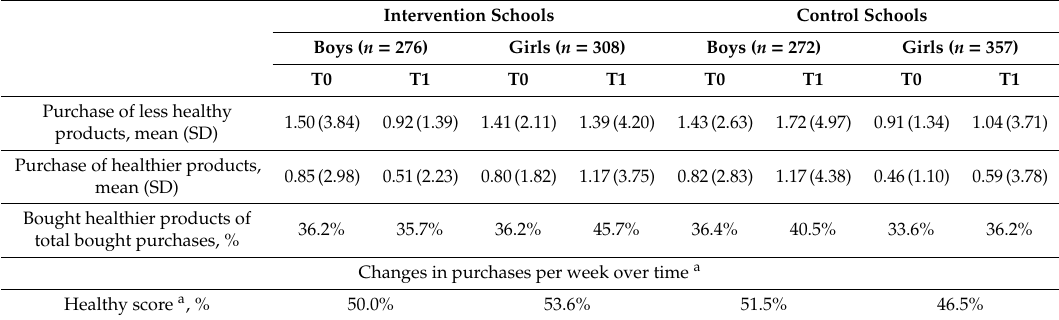
Table 3. Weekly food and drink purchases in the cafeteria.